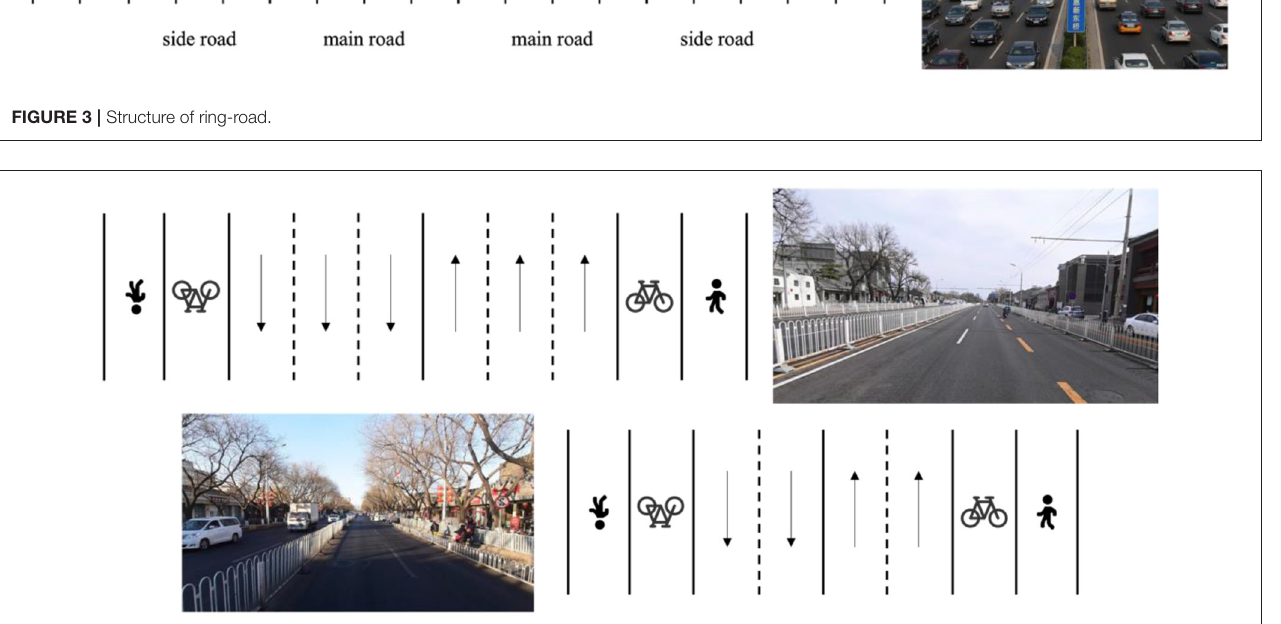
FIGURE 4 | Structure of arterial road.